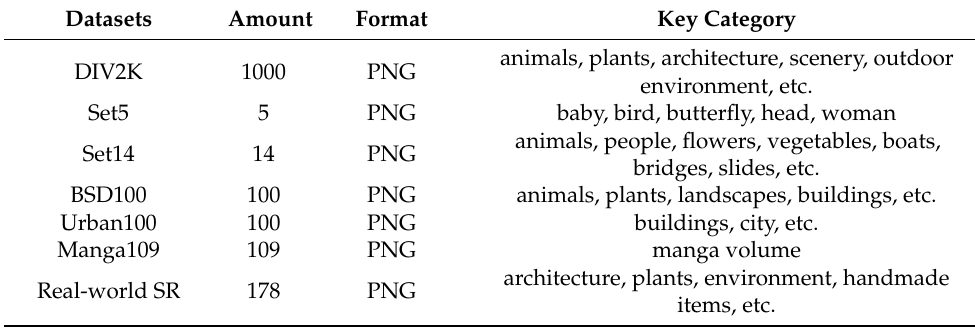
Table 1. The main characteristics of the public